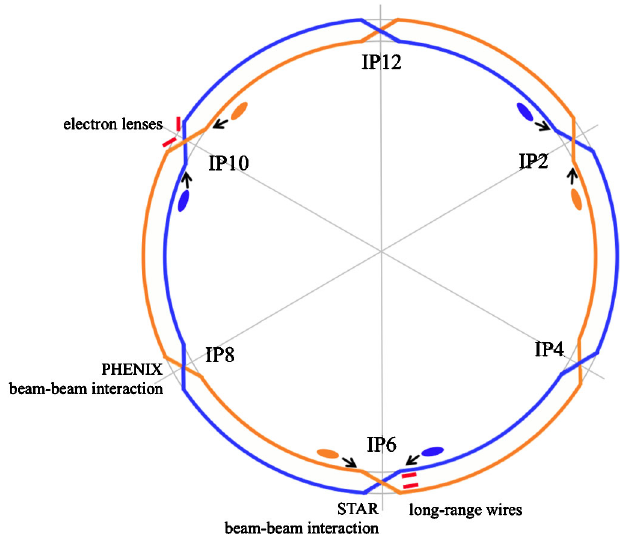
FIG. 1. Beam-beam interactions in RHIC and locations of wires and